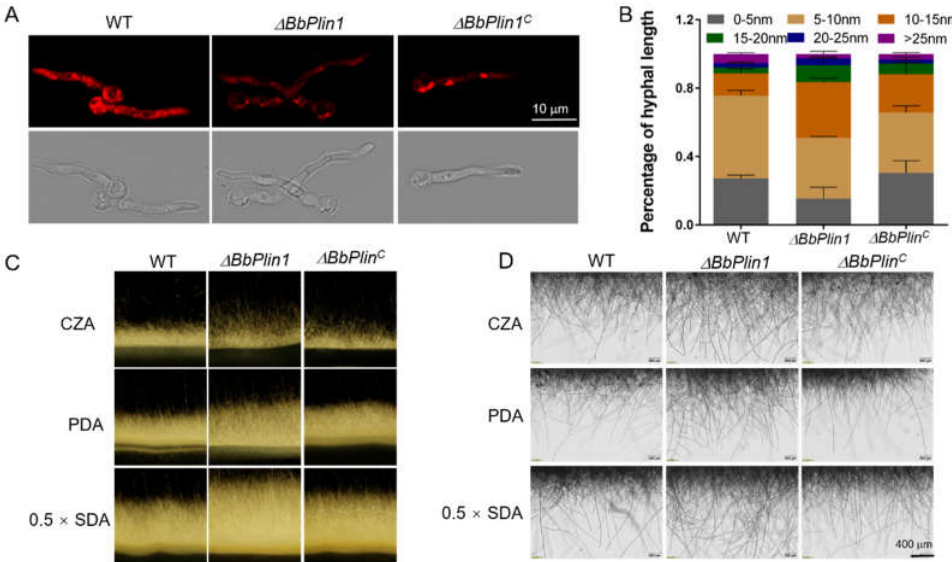
Figure 3. BbPlin1 affects LD formation and hyphal growth. ( A ) The B. bassiana wild–type and Δ BbPlin1 strains were inoculated into CZB and cultured for 20 h after which fungal cells were collected by centrifugation, stained with Nile Red, and visualized by fluorescent microscopy, as described in Materials and Methods. ( B ) Quantitative measurement of fungal hyphal lengths. Fungal conidia were cultured on CZA for 16 h and the hyphal length was measured microscopically via ImageJ analyses. ( C , D ) Effects of BbPlin1 on aerial hyphae growth. Conidial suspensions of wild–type and mutant strains were inoculated onto CZA, PDA, and 0.5 × SDAY media placed into the space between two glass slides, as described in the Materials and Methods. Samples were cultured at 26 °C for 3 d and observed by a fluorescent macroscopic stereomicroscope and automatic inverted DIC microscopy.